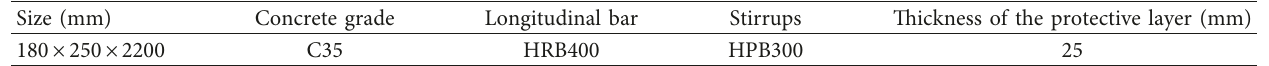
Table 1: Reinforced concrete beam design.